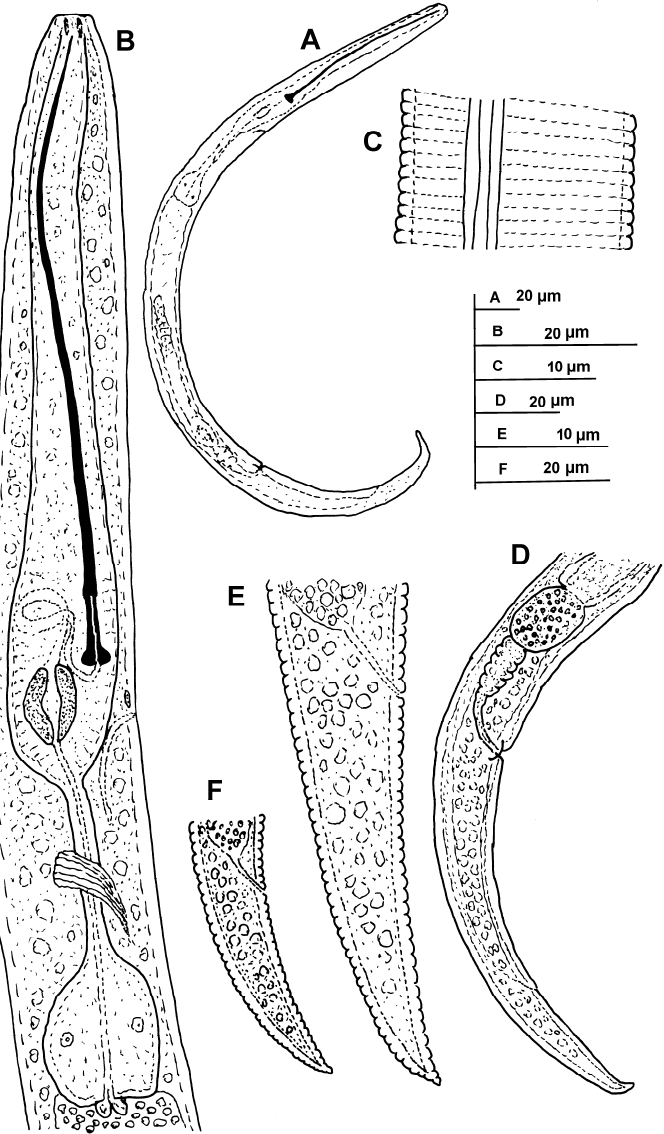
Figure 1. Line illustrations of Paratylenchus paraaonli sp. nov. ( A ) Whole female body; ( B ) Female pharyngeal region; ( C ) Detail of lateral field at mid-body; ( D ) Female posterior region; ( E , F ) Female